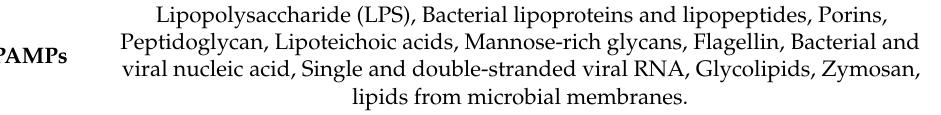
Table 1. PAMPs (pathogen-associated molecular patterns) and DAMPs (damage-associated molecular patterns) responsible for inflammasome activation.